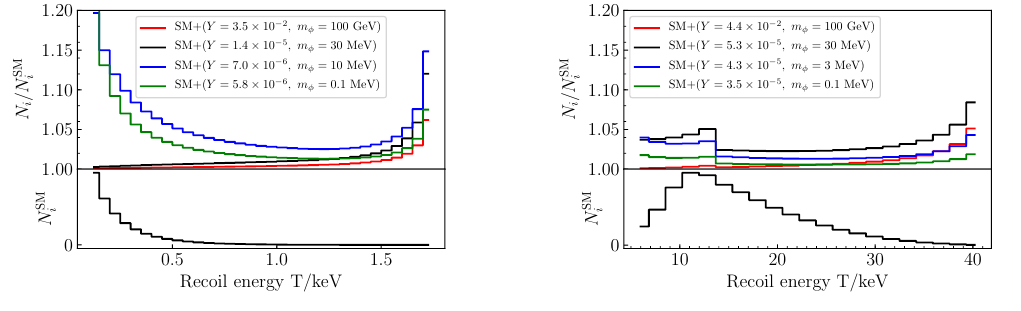
Figure 3 . Event excess caused by light scalar bosons in CONUS (left) and COHERENT (right). The e(cid:11)ective coupling Y is de(cid:12)ned in eq. (2.18) and its dependence on the fundamental